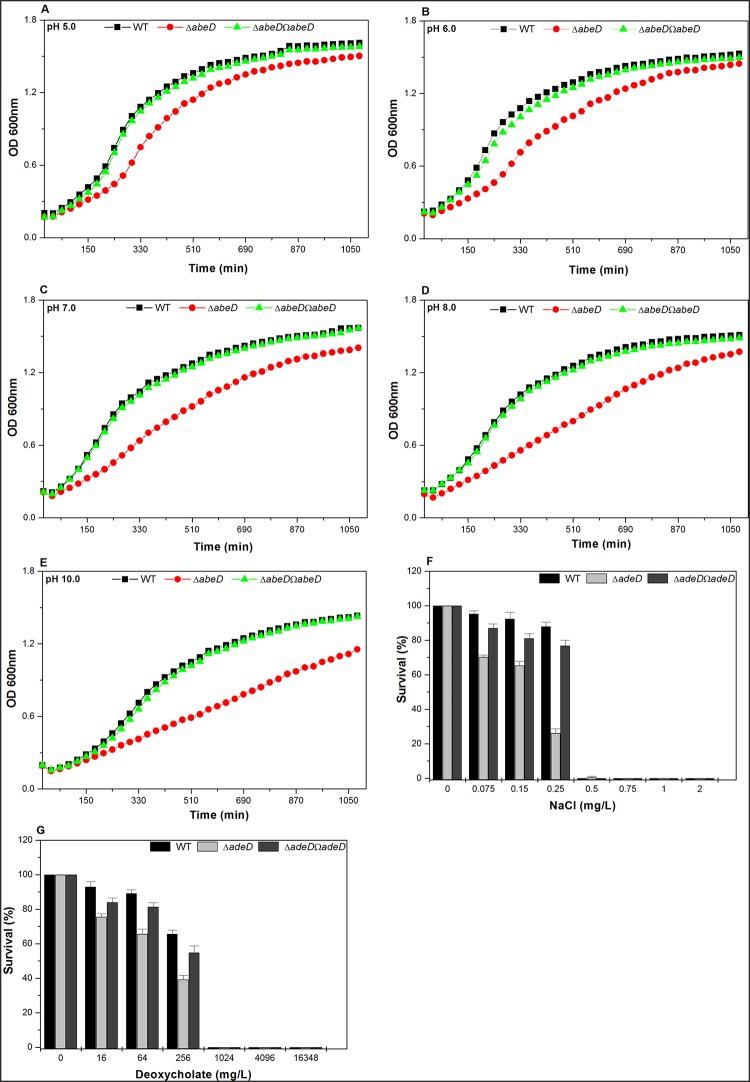
Impact of abeD disruption on growth and physiology in A. baumannii.The influence of AbeD on growth of bacteria was monitored in WT, ΔabeD and ΔabeDΩabeD in LB medium at pH (5.0 (A), 6.0 (B), 7.0 (C), 8.0 (D), 10.0 (E). The average of independent experiments done three times is used to plot the graph. The survival capability of native strain to grow in the presence of NaCl was monitored and it was higher when compared to ΔabeD regardless of the inoculum size (F). The capacity of WT to grow in the presence of deoxycholate was compared to ΔabeD, the completely transcomplemented ΔabeDΩabeD strain restored the ability to tolerate the stress (G).